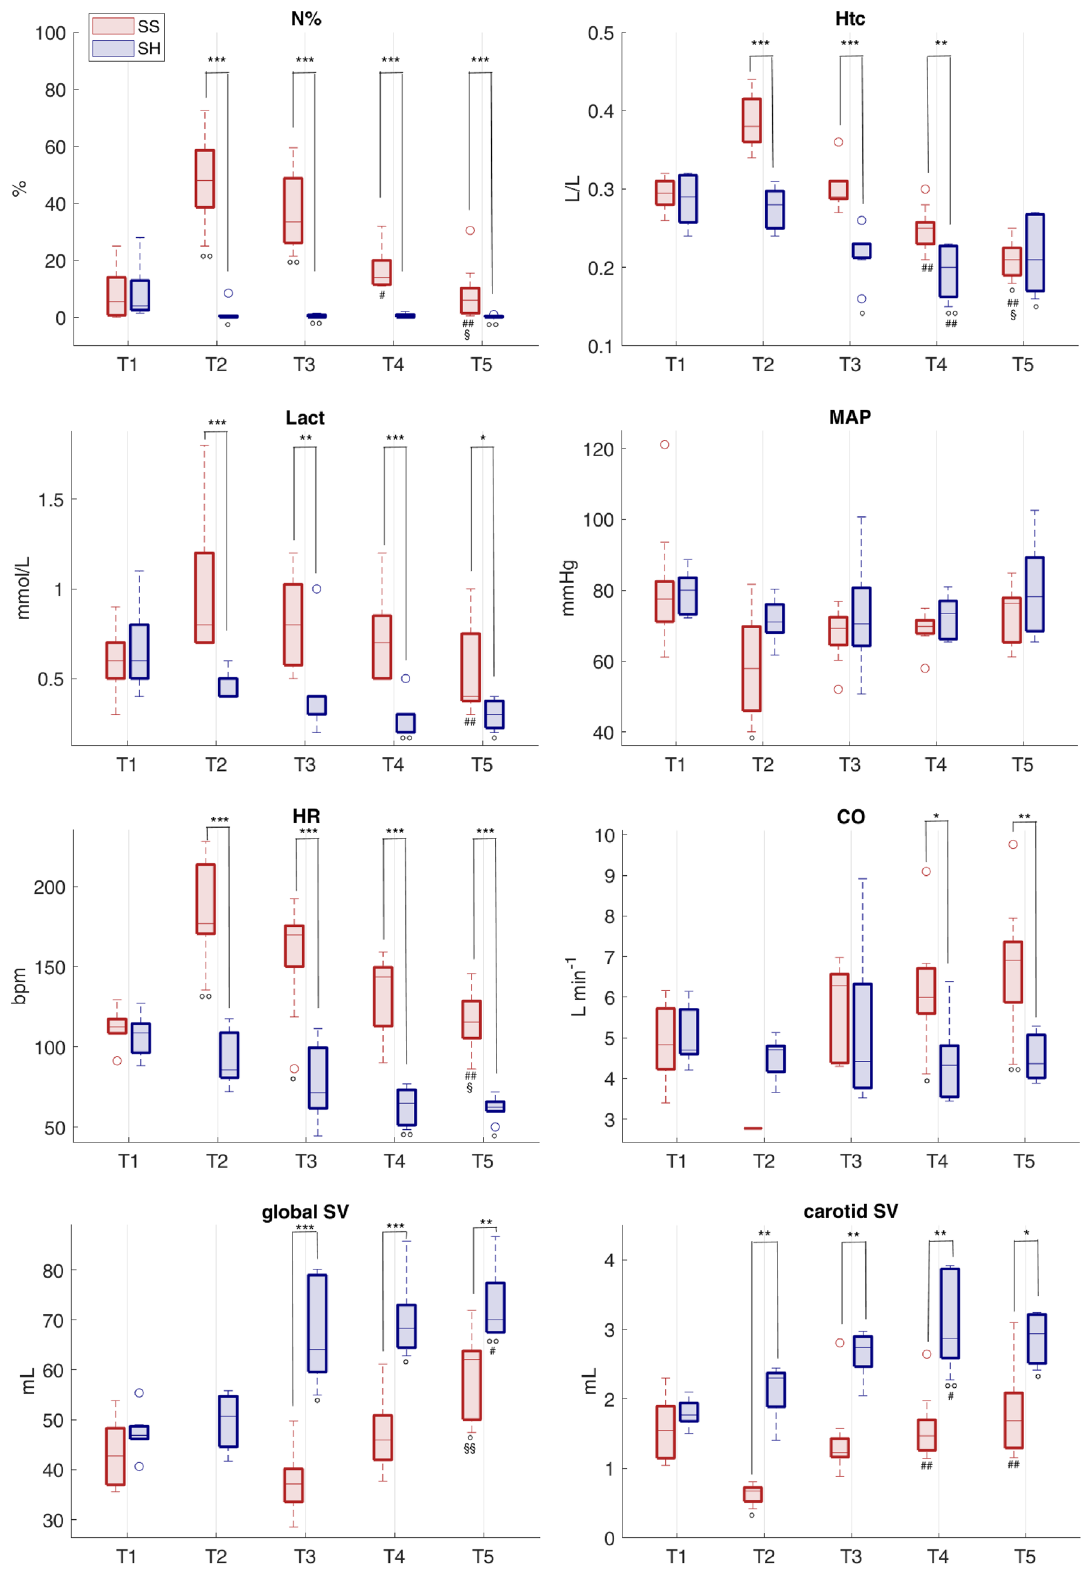
Figure 1. Distributions of laboratory data and hemodynamic variables for the two groups at each time point. Comparison between Sepsis and Sham: * p -value < 0.05, ** p -value < 0.01, *** p -value < 0.001 (Wilcoxon rank sum test). Wilcoxon signed test: ° p -value < 0.05, °° p -value < 0.01 with respect to T1, # p -value < 0.05, ## p < 0.01 with respect to T2, § p -value < 0.05, §§ p -value < 0.01 with respect to T3 (Friedman test p -value < 0.05). N% = band neutrophils, Htc = hematocrit, Lact = arterial lactate, MAP = mean arterial pressure, HR = heart rate, CO = cardiac output, global SV = global stroke volume, carotid SV = carotid stroke